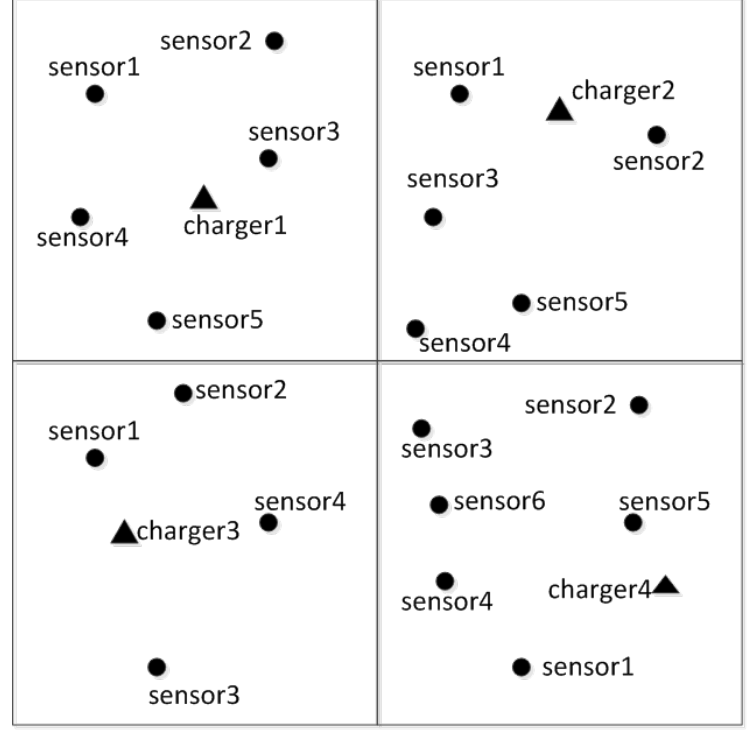
Figure 12. Overall area